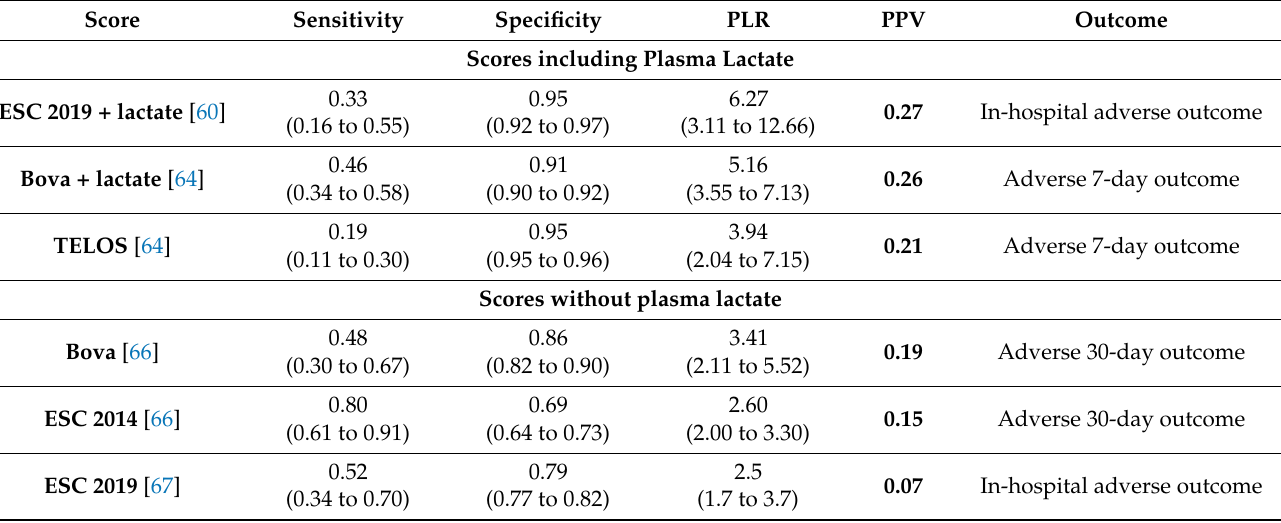
Table 5. Prognostic value of stratification scores dichotomized at an intermediate–high-risk